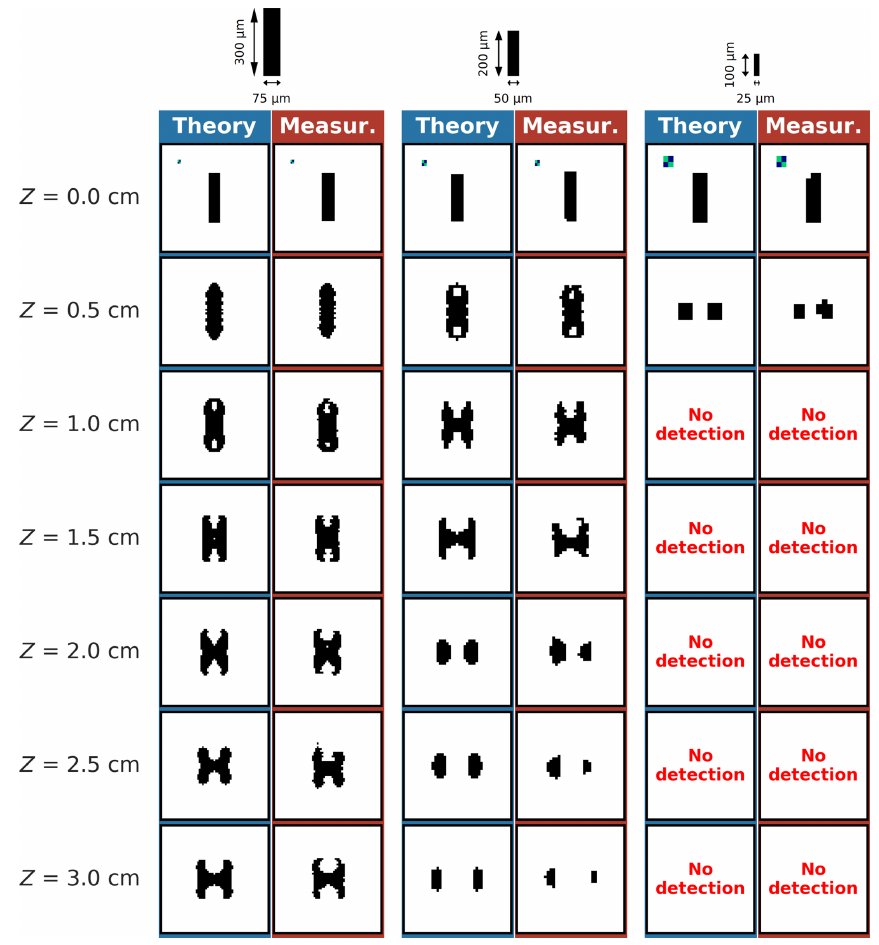
Figure 6. As Fig. 5 for 1 : 4 (width:height) opaque rectangular planar shape particles (elongated